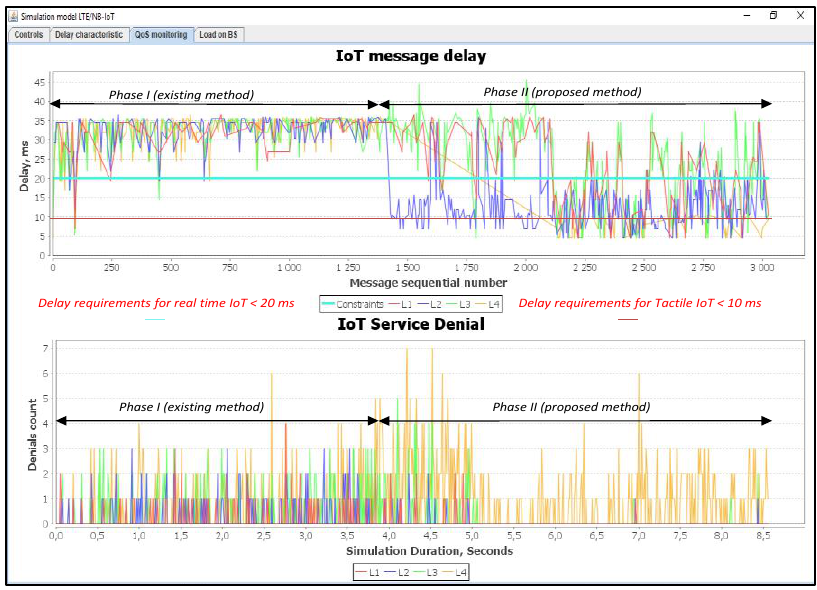
Figure 20. Delay and service denials from IoT devices (average load of IoT controller ρ = 75%).